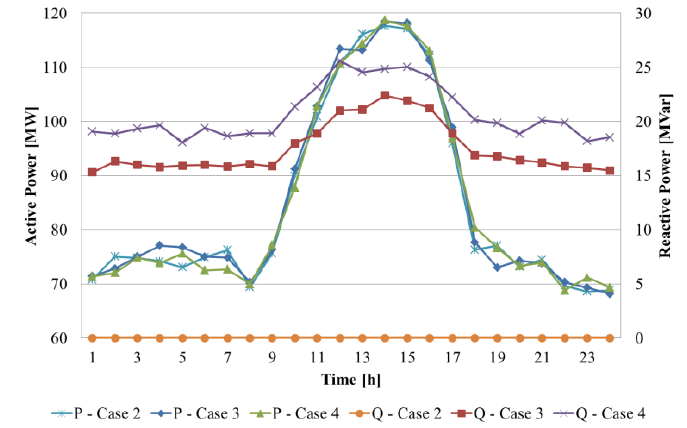
Figure 10. Active and reactive power according to power factor.